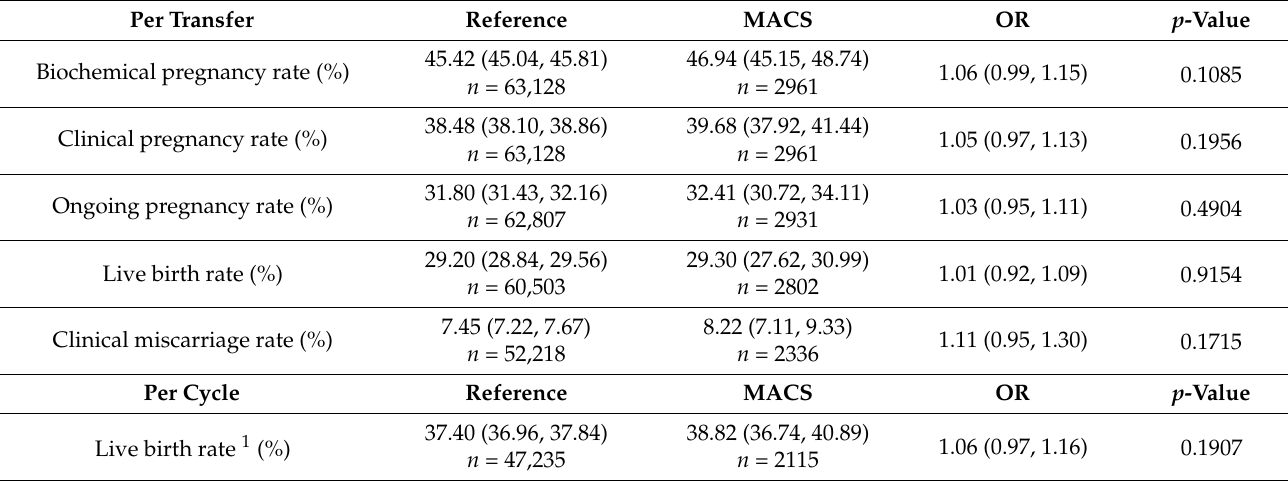
Table 2. Results from the unadjusted analysis of gestational outcomes in cycles using autologous oocytes. The proportions for each group and the odds ratio (OR) are displayed with their corresponding 95% CI. The proportions are also shown with the sample number, either transfers or initiated cycles, for each of the outcome measurements. The p -value was computed using the Fisher’s exact